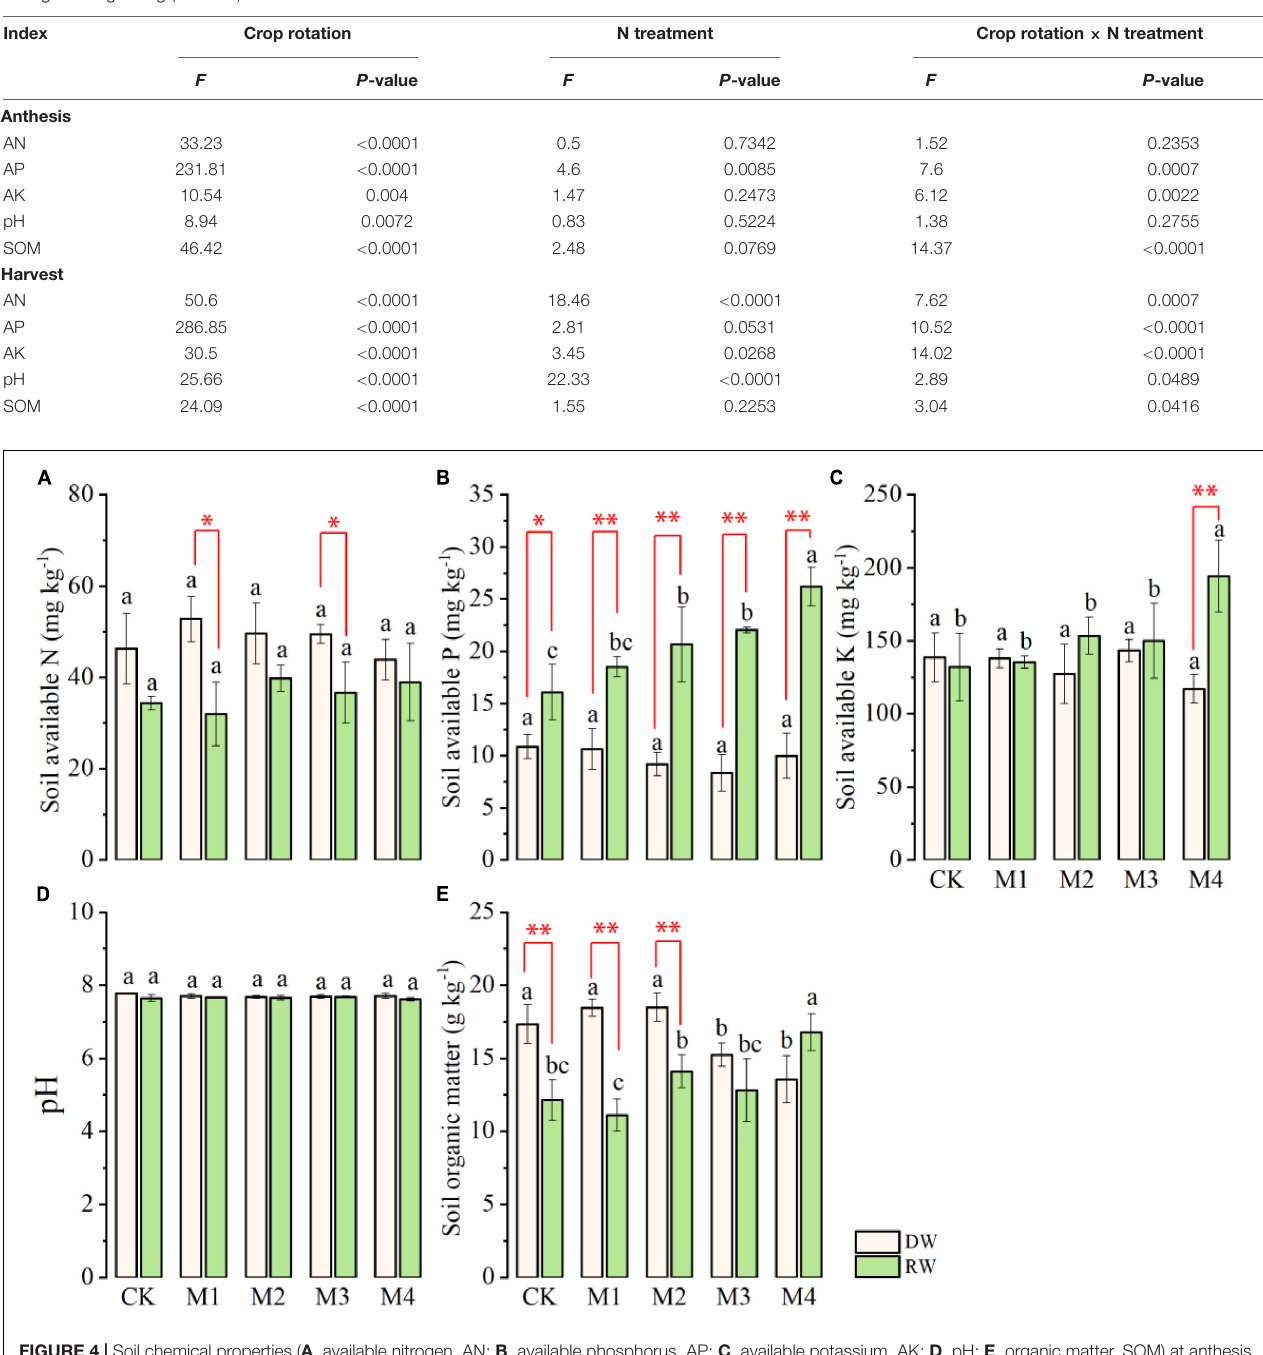
TABLE 2 | Analysis of variance (ANOVA) of available N (AN), available P (AP), available K (AK), pH and organic matter (SOM) as affected by crop rotation and N treatment during wheat growing (anthesis) and after wheat harvest.